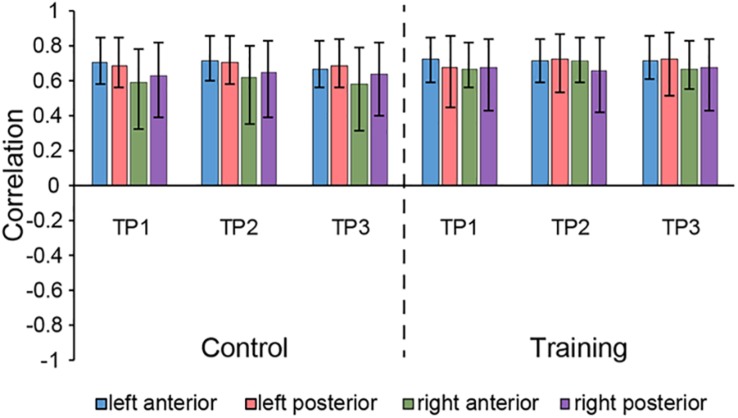
Correlations between brain scores and seed-region volumes in LV1, showing similar covariance of the bilateral aHC and pHC comparable within each group across three time points. Bars describe the relation of each seed to the structural covariance pattern. The error bars represent 95% bootstrapped confidence intervals. A lack of overlap in interval indicates reliable difference for any two correlations and overlap with 0 means the correlation is not significantly different from 0.